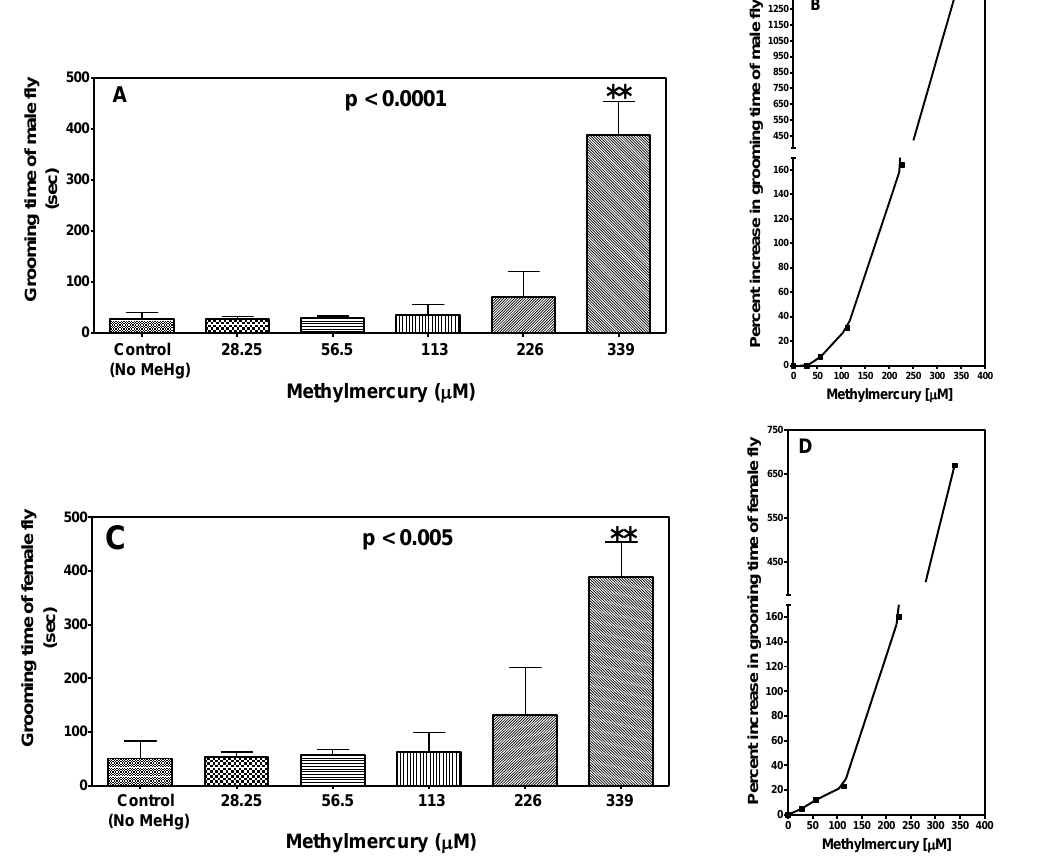
Figure 2. Effect of MeHg exposure on the grooming time in male and female flies. ( A , C ) represent MeHg-dependent effect on grooming time in male and female flies, and ( B , D ) show corresponding MeHg-induced percent increase in grooming time. Data are presented as Mean ± S.E.M of four independent experiments. ** p < 0.01 as compared to controls, ANOVA (Dunnette).